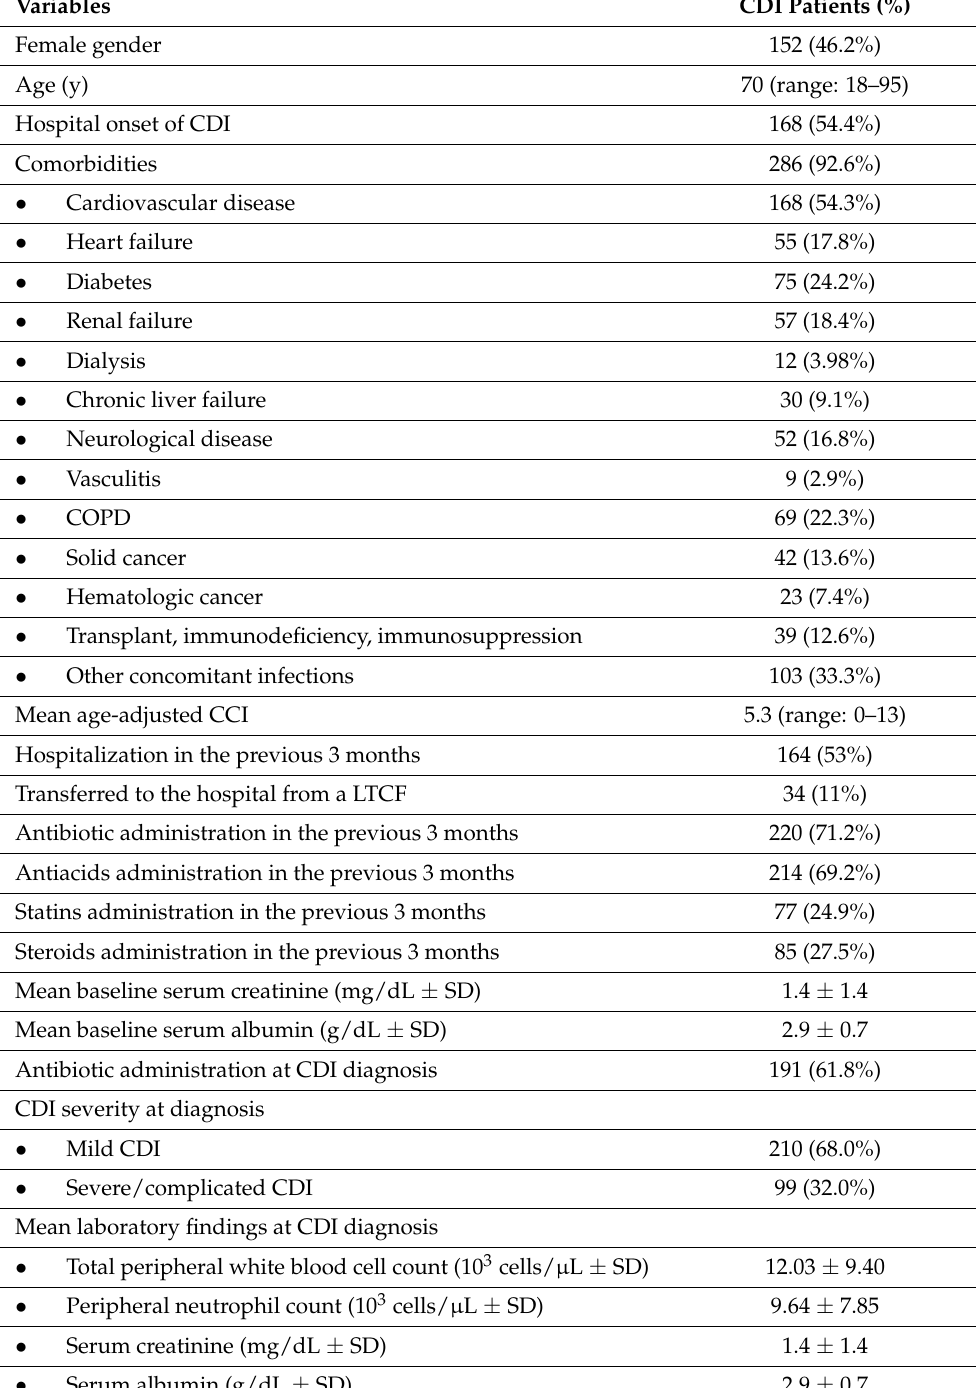
Table 1. Baseline characteristics of the 309 patients with a first CDI included in the study. CCI: Charlson Comorbidity Index; SD: standard deviation; CDI: Clostridioides difficile infection; COPD: chronic obstructive pulmonary disease; LTCF: long-term care facility. SD: standard deviation. Variables CDI Patients (%) Female